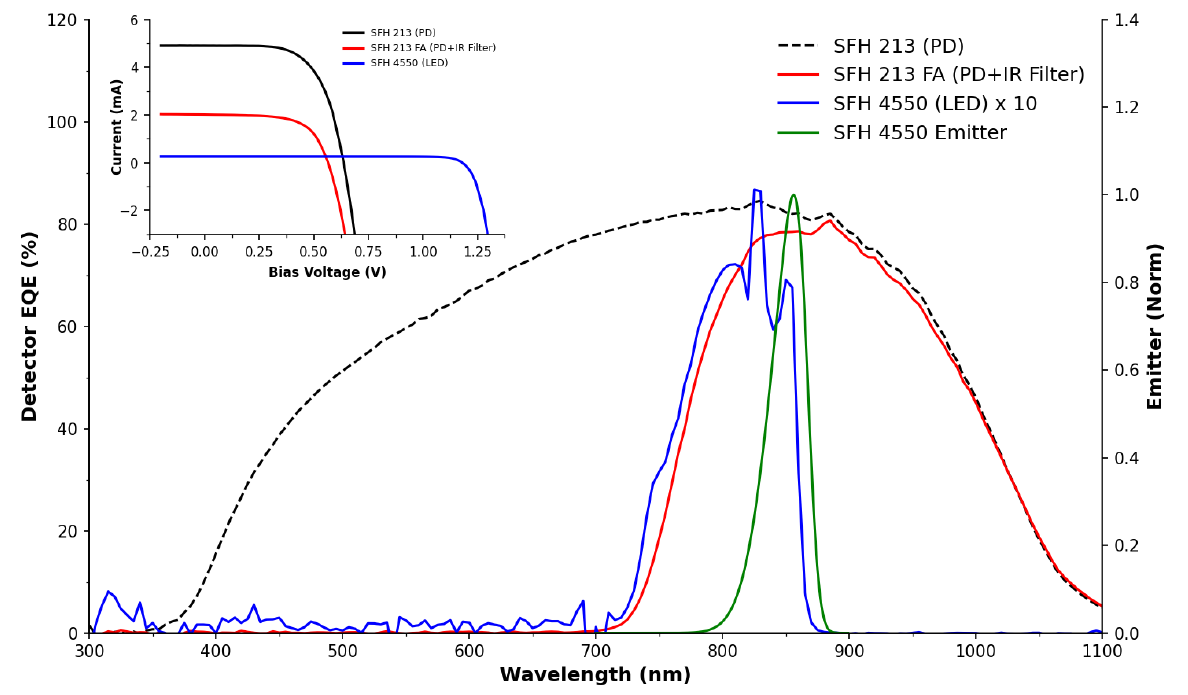
Figure 2. Spectral response of the photodiode (with and without the IR filter) and the LED in detector mode from 300–1000 nm. For reference the LED emission spectra model is shown ( R 2 = 0.9939, normalised [0, 1]). Inset: Current-voltage responses of the PD and LED (detector) devices under simulated AM1.5